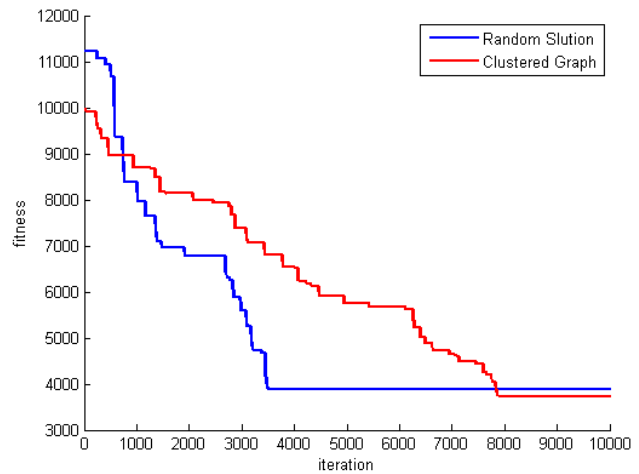
ff ect of graph clustering on Figure 18. The effect of graph clustering on convergence. Figure 18. The e